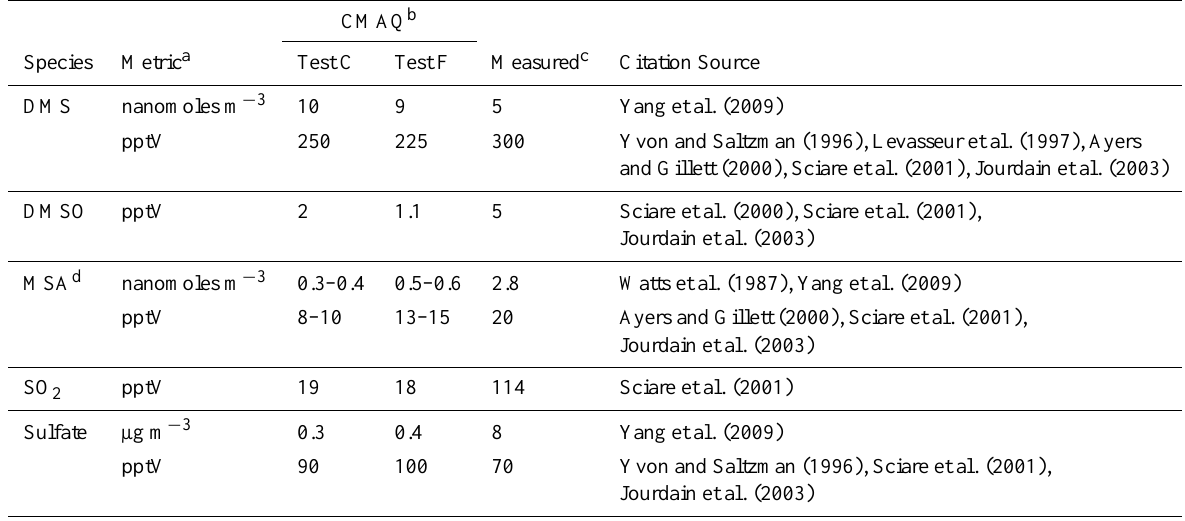
Table 9. Modified CMAQ4.6 simulated levels of sulfur compounds in the marine boundary layer compared with values from other sources.